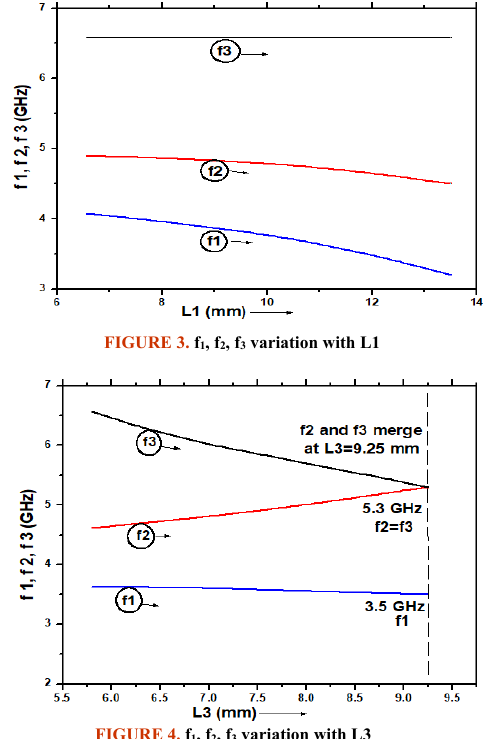
FIGURE 4. f 1 , f 2 , f 3 variation with